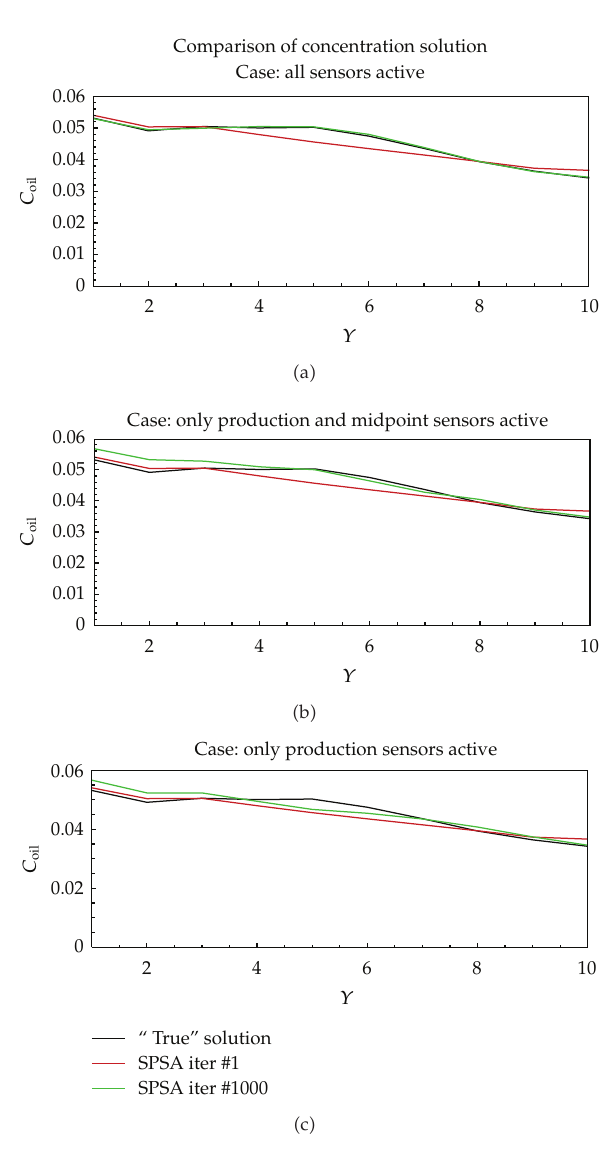
Figure 3: Example 1: history matching of oil phase concentrations based on sensor